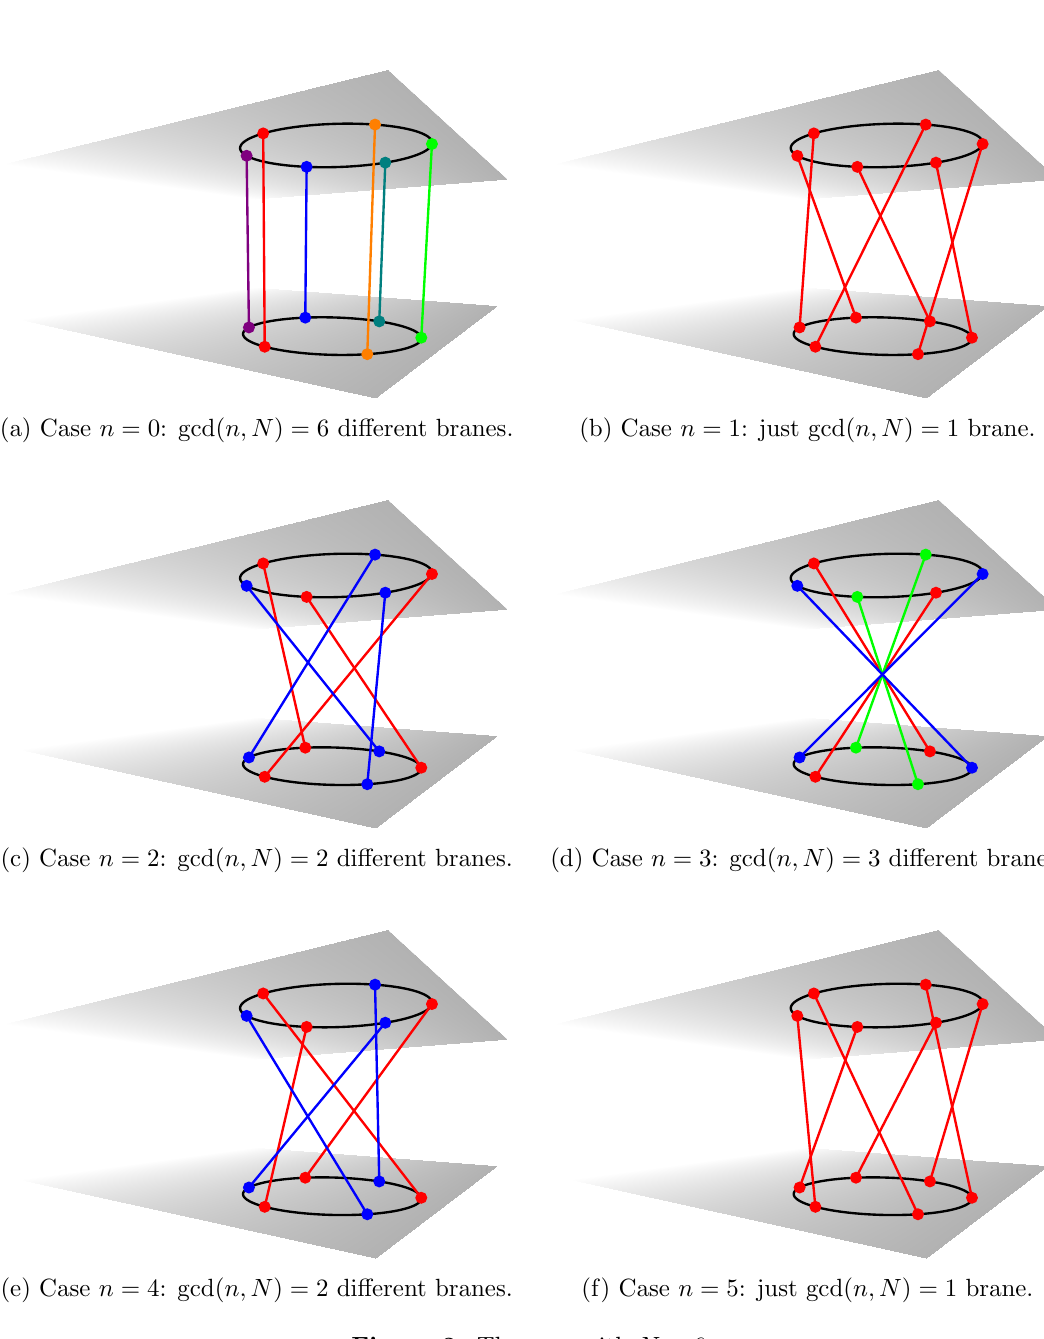
Figure 3. The case with N =